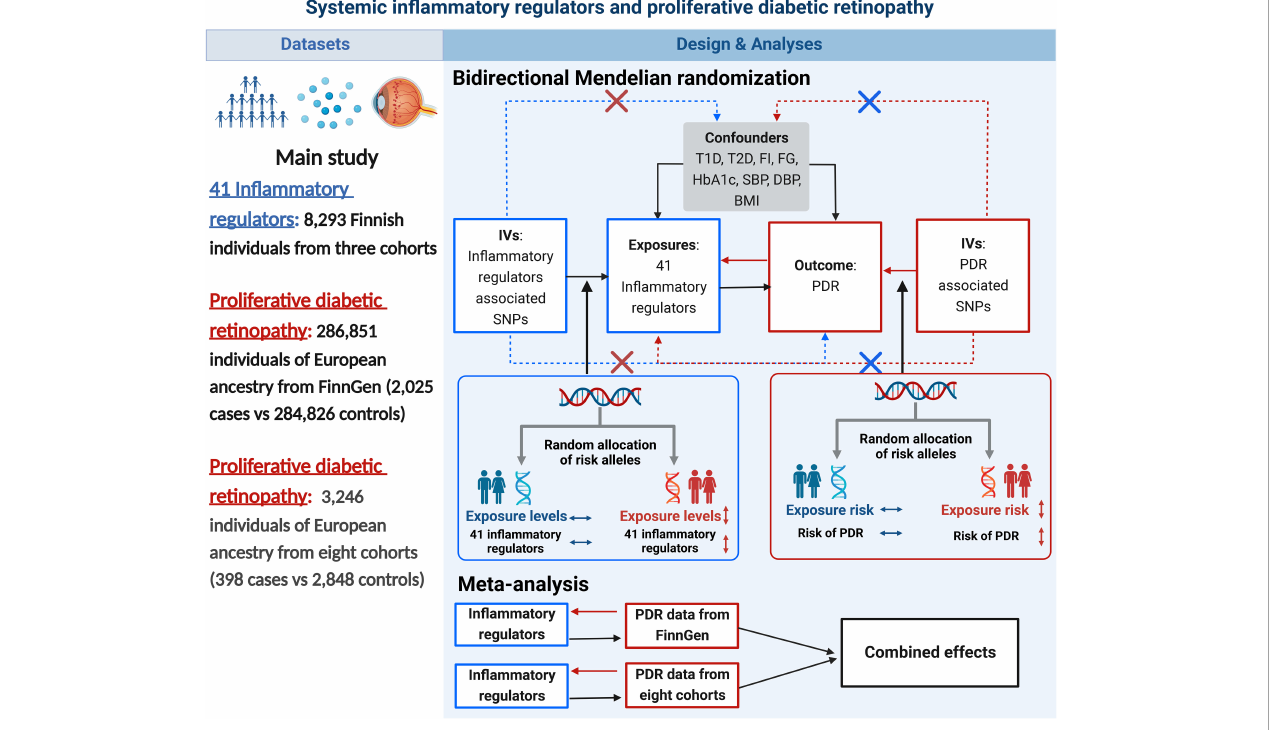
FIGURE 1 Datasets, assumptions, and study design of the bidirectional Mendelian randomization study of the associations between 41 in fl ammatory factors and PDR. BMI, body mass index; DBP, diastolic blood pressure; FG, fasting glucose; FI, fasting insulin; IVs, instrumental variables; PDR, proliferative diabetic retinopathy; SBP, systolic blood pressure; SNPs, single-nucleotide polymorphisms; T1D, type 1 diabetes; T2D, type 2